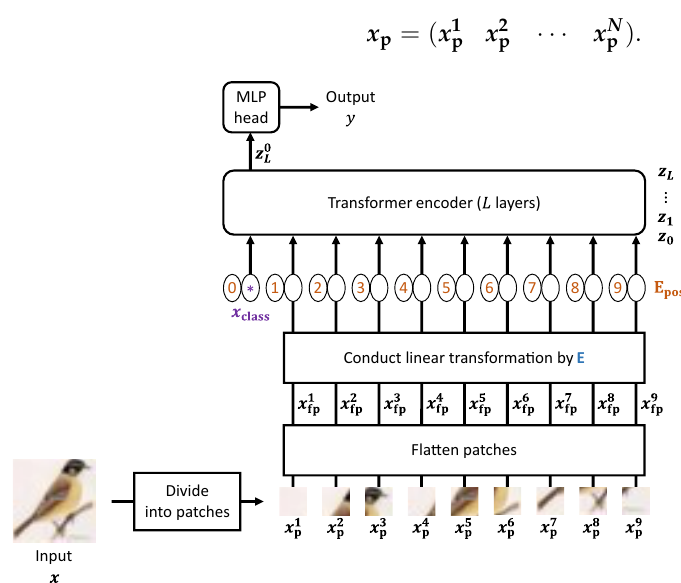
Figure 1. Overview of ViT